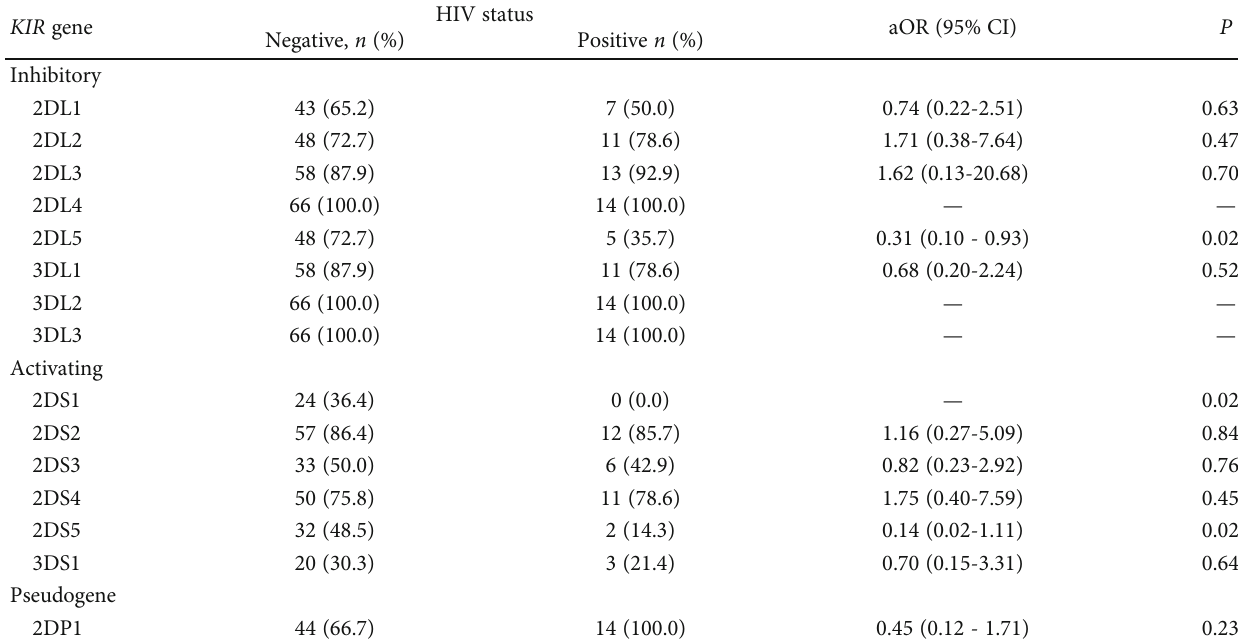
Table 2: KIR gene frequencies strati fi ed by disease status.